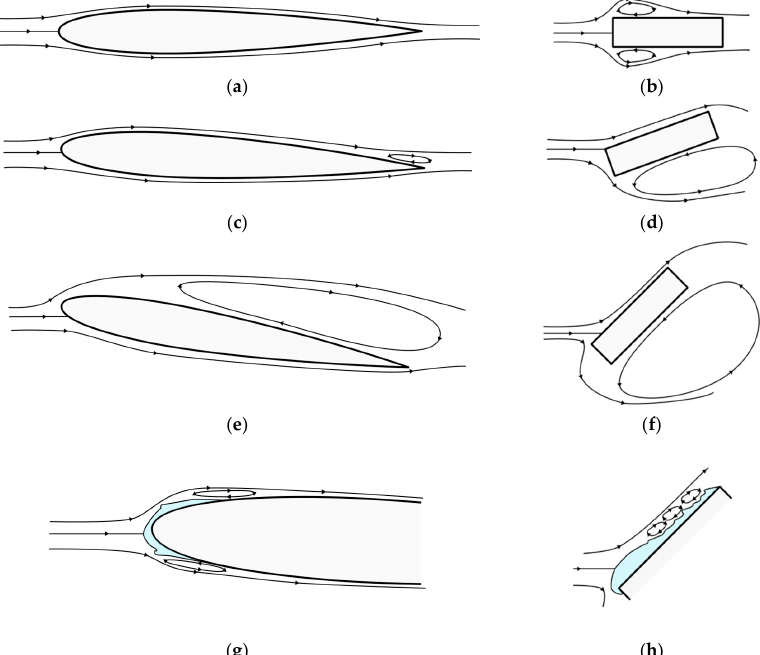
Figure A2. Pathlines over NACA 0012 and flat-plate sample holders at various angles of attack and with an arbitrarily low Reynolds Number. ( a ) Airfoil at 0° angle of attack (AoA) showing symmetric pathlines without flow separation; ( b ) Block holder at 0° AoA showing symmetric pathlines with flow separation and reattachment; ( c ) Airfoil at 3° AoA showing slightly asymmetric pathlines and flow separation at the trailing edge on the suction side; ( d ) Block holder at 20° AoA showing stagnation at the leading corner, and attached flow along the top side; ( e ) Airfoil at 10° AoA showing asymmetric pathlines and flow separation along the entire suction side; ( f ) Block holder at 45° AoA showing an elevated stagnation point and attached flow on the top side; ( g ) Iced airfoil at 3° AoA showing slightly asymmetric pathlines with small flow separations immediately downstream of the ice; ( h ) Iced block holder at 45° AoA showing uneven ice with complete coverage of the top side and a series of small flow detachments due to the ice shape; ( a ), ( c ), ( e ), and ( g ) are based on [31]. ( b ), ( d ), and ( f ) are reproduced from [26].